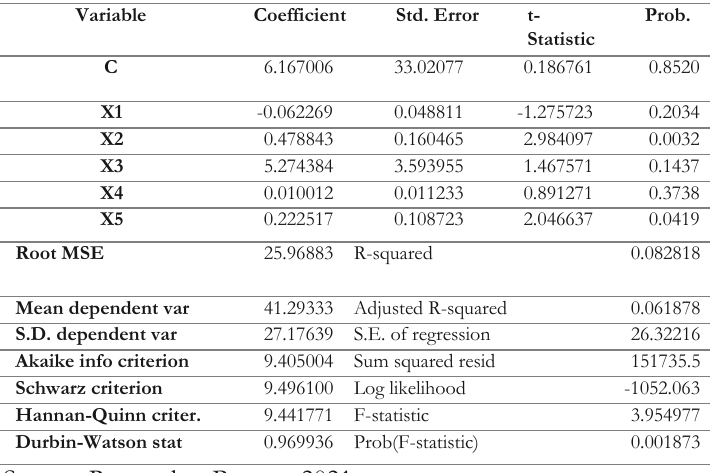
Table 4 Common Effect Model (CEM) Test